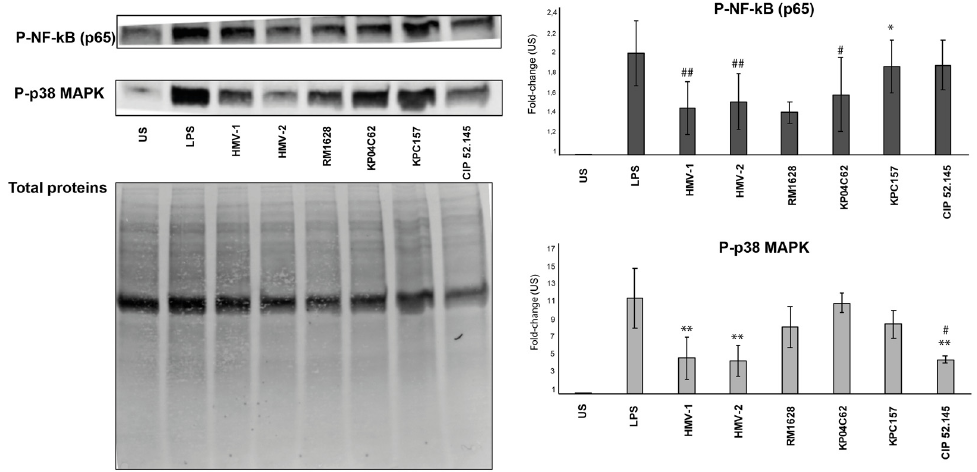
Figure 4. NF-kB (p65) activation and p38-MAPK phosphorylation by DCs. Dendritic cells were cultured in the absence (US) or presence of K. pneumoniae strains or LPS as a positive control. Cells were analyzed by Western blot analysis. Data from one representative experiment out of three performed are shown. Data are expressed as the fold increase of each experimental point over unstimulated control. A t -test was performed comparing KP04C62 (*) and KPC157 (#) (non-Hv-HMV strains) with the Hv-HMV Kp strains. We considered statistical significance as a p -value < 0.05 (*, #); p -value < 0.01, (**, ##).